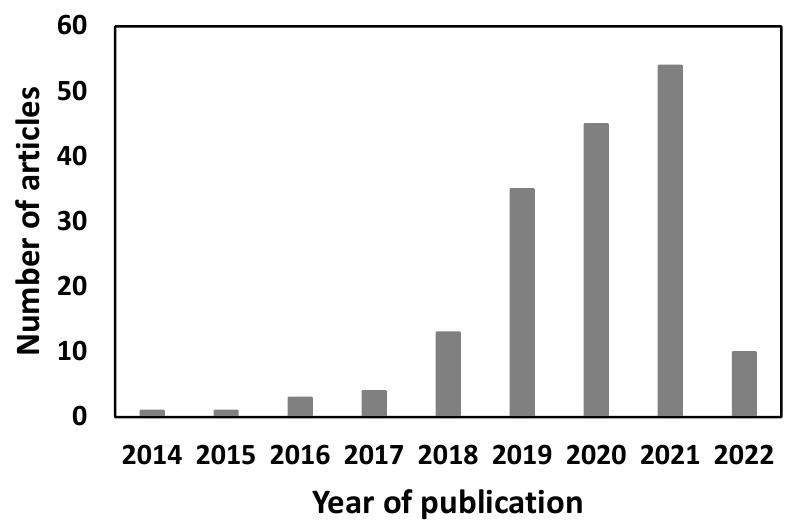
Figure 2. Yearly distribution of research articles on MPs in freshwater environments .